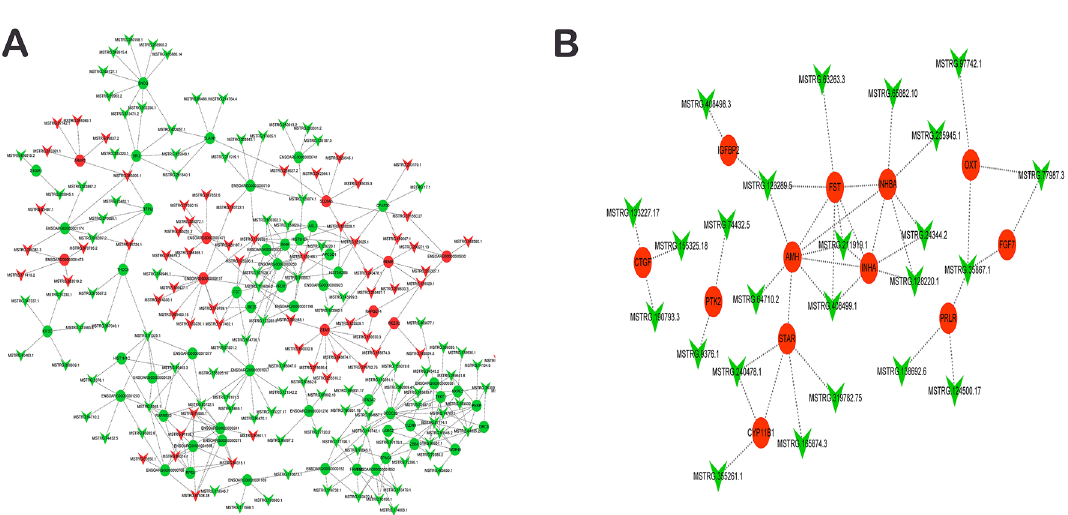
Figure 4. Co-expression network of lncRNAs and differentially expressed mRNAs related to ovarian development in H1 vs H3 ( A ) H3 vs H8 ( B ). Triangle and circle nodes represent lncRNAs and mRNAs, respectively. The nodes with red colour represent up-regulation whiles those with green colour represent down- regulation. The dotted line represents the target relationship between two